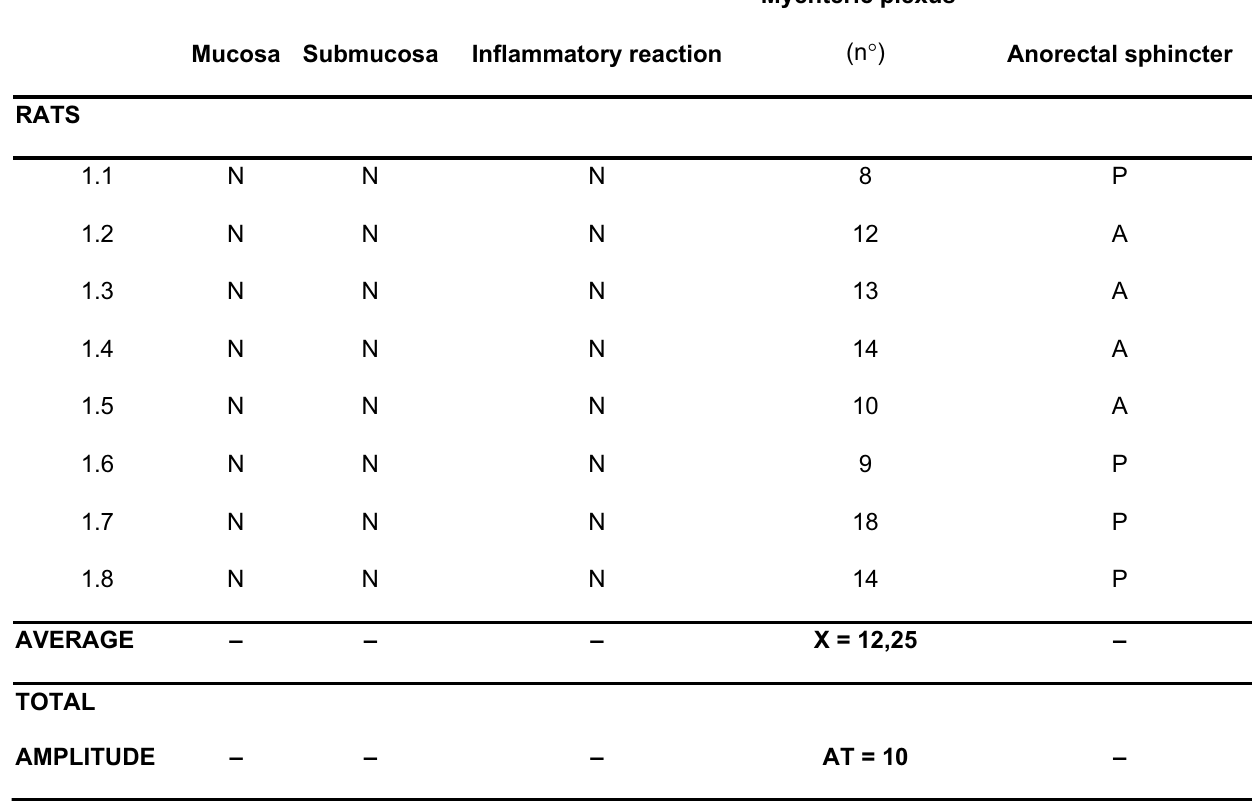
LEGEND: N = normal; P = present; A =